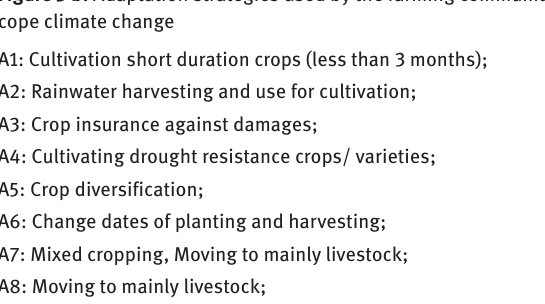
Figure 3 a: Adaptation strategies used by the farming community to cope climate change Figure 3 b: Adaptation strategies used by the farming community to cope climate